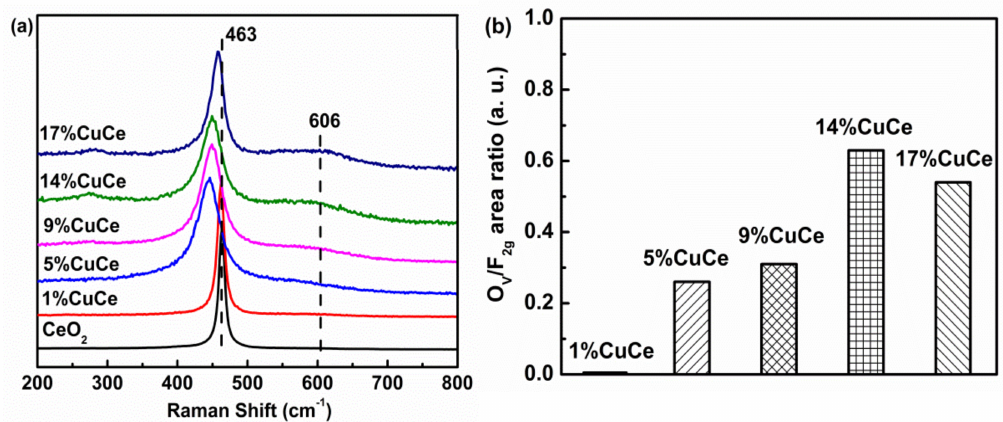
Figure 3. ( a ) Raman spectra for the prepared samples; ( b ) O v /F 2g area ratios of the Cu-containing